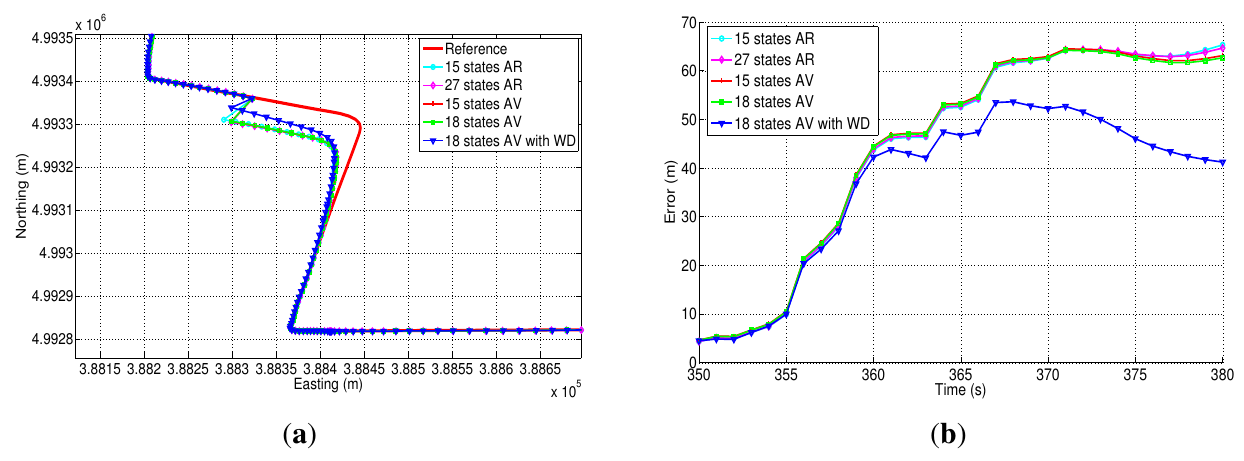
Figure 25. ( a ) Horizontal position during GPS outage 7; ( b ) horizontal position error during GPS outage 7.